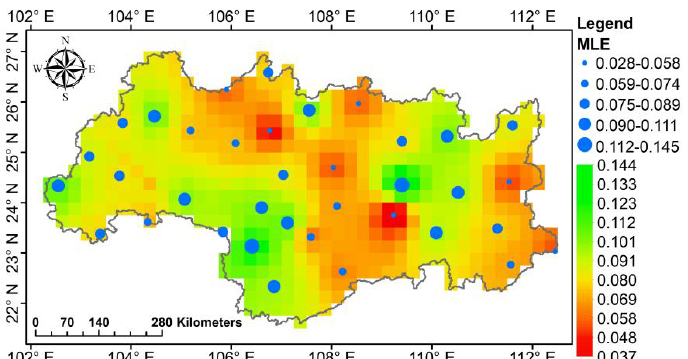
Figure 11. Spatial distribution of the largest Lyapunov exponent across Xijiang River Basin between 1989 and 2008.